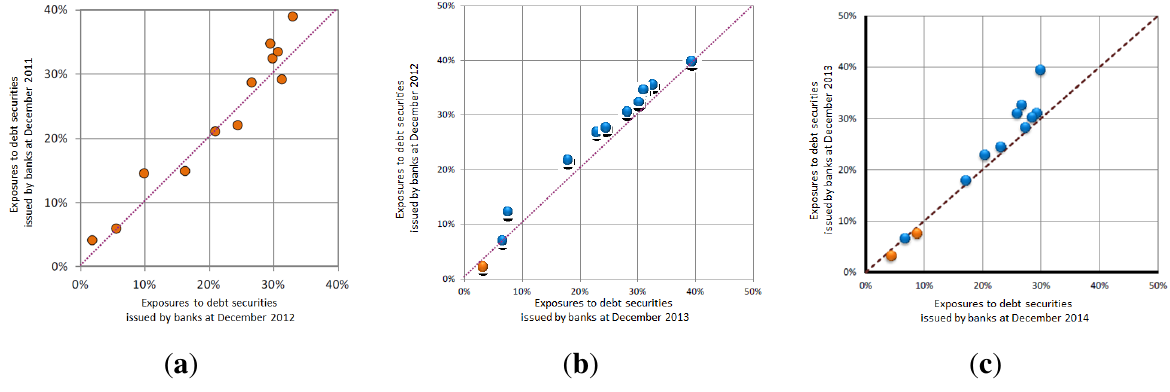
Figure A3. Annual change of investment of the major French insurers through debt securities between December 2011 and December 2014. Each dot represents one insurer. When dots are colored, a blue dot indicates a decrease, while a yellow dot indicates an increase. Sources: ACP [46] for ( a ), ACPR [47] for ( b ) and ACPR [45] for ( c ). (a) Between 2011 and 2012; (b) between 2012 and 2013; (c) between 2013 and